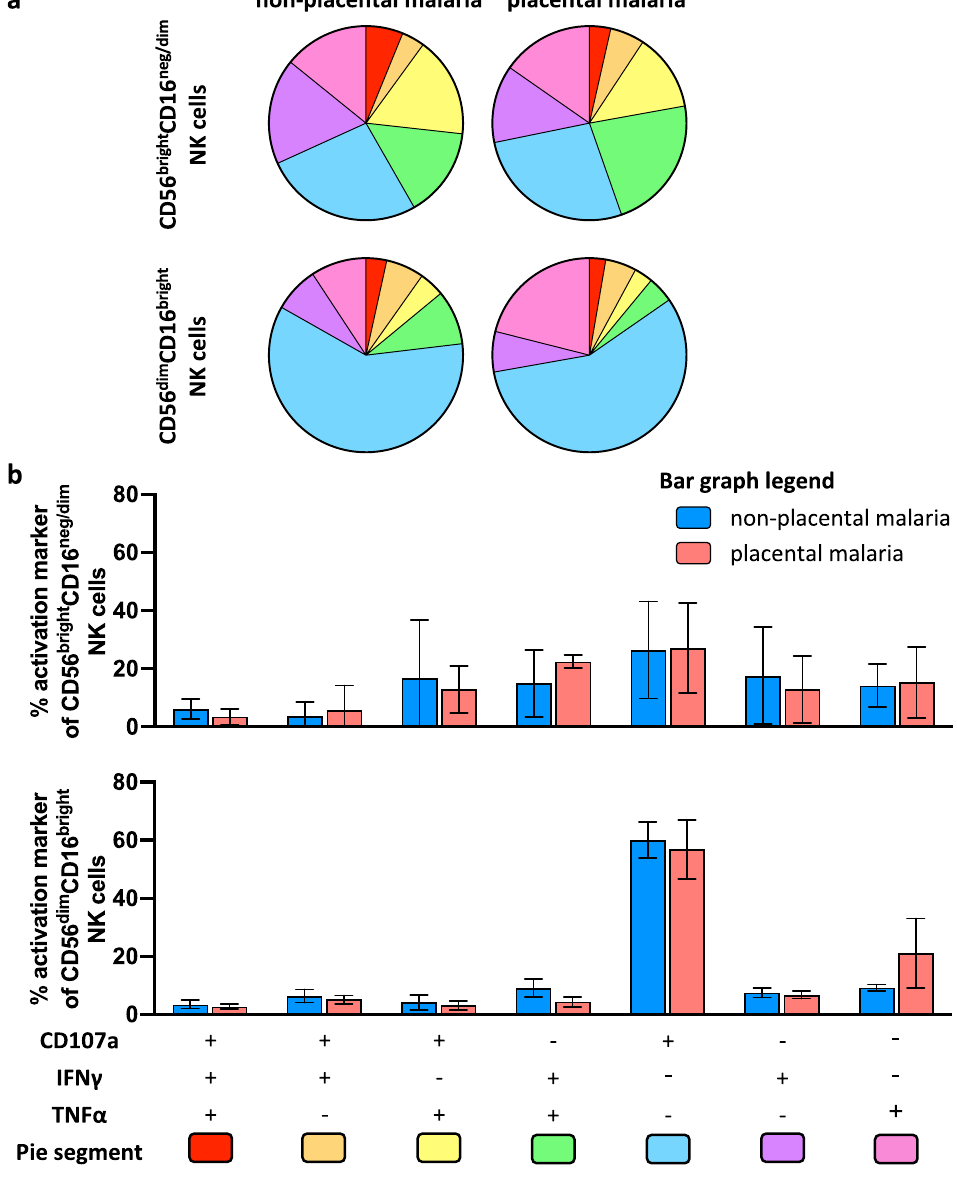
Figure 4. Polyfunctional responses of NK cells induced by DBL2-specific Abs from pregnant women with malaria. NK cells from three separate donors were stimulated with IgG from pregnant women mid pregnancy with non-placental malaria (N = 27), women with placental malaria (N = 50) at delivery in presence of DBL2 and assessed for expression of CD107a, IFNγ and TNFα. ( a ) NK cells were selected based on their CD56 expression (CD56 dim and CD56 bright ). Pie and Bar charts show the proportion ( b ) and relative frequency ( c ) of each activation marker combination of only activated NK cells. ( b ) The pie segments correspond to NK cells expressing different combinations of activation markers and are color coded (pie segment legend: pink- red) to indicate increasing polyfunctional NK cell activation. ( c ) The bar graph shows relative frequencies of combinations of activation markers by NK cells stimulated with IgG from non-placental malaria-infected women (blue) or women with placental malaria (red) in presence of DBL2. Mean of three NK cell donors with standard deviation is shown. Statistical analysis between groups was performed using multiple t tests corrected for multiple comparisons using the Holm-Šídák